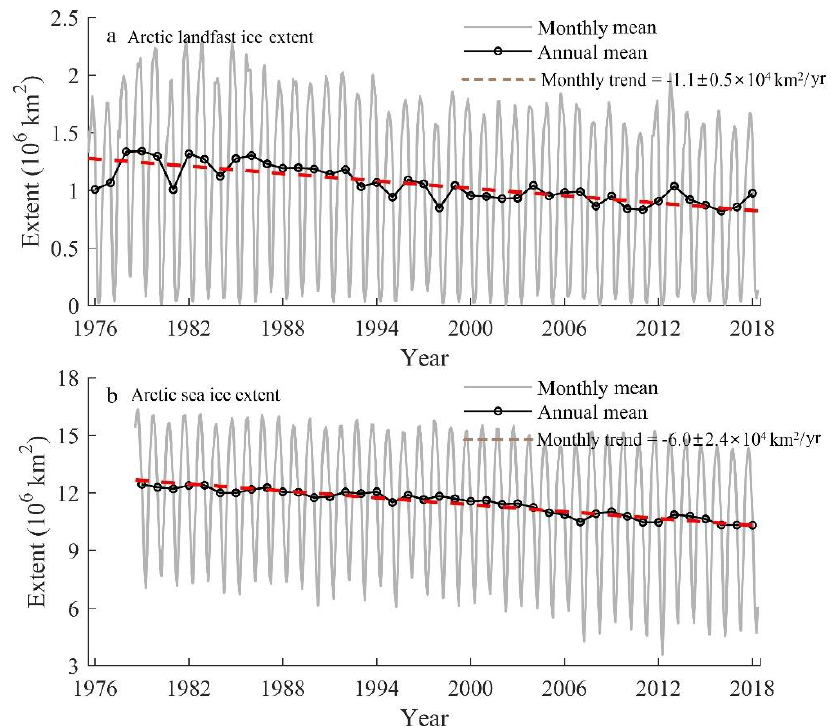
Figure 4. Comparison of long-term trends in the Arctic sea ice extent and landfast ice extent.